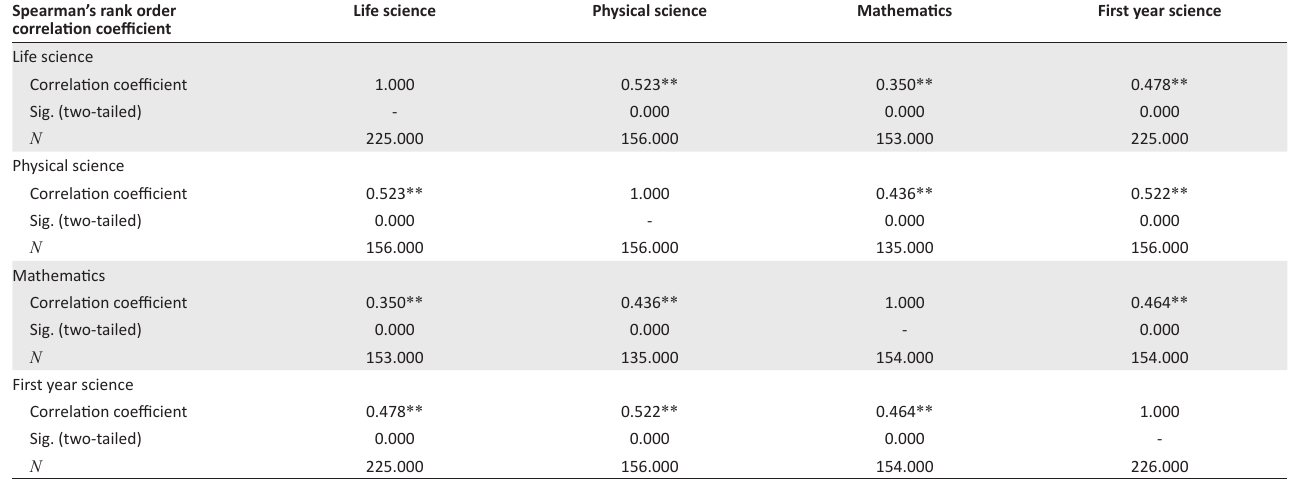
TABLE 2: Spearman’s rank order correlations between study variables. Spearman’s rank order correlation coefficient